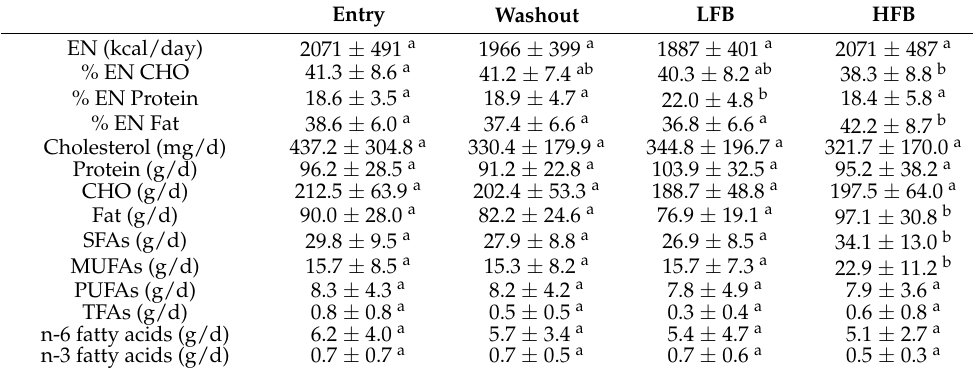
Table 3. Daily macronutrient intake.